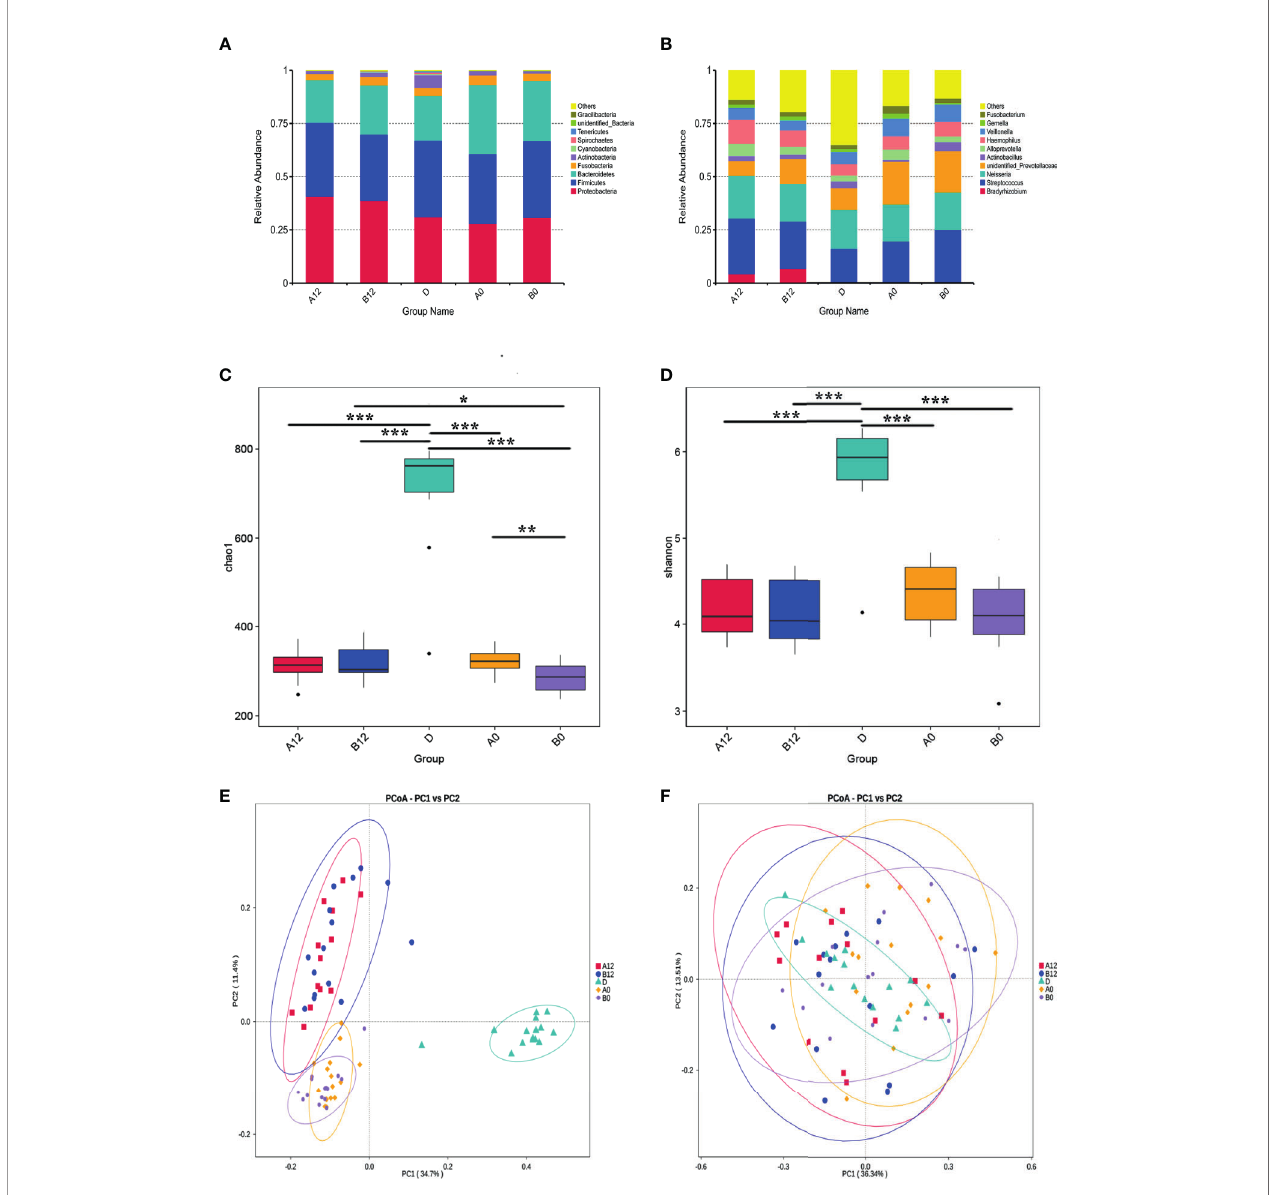
FIGURE 1 | The composition, relative abundance, and diversity of oral microbiota in HIV-infected groups and controls (A) at the phylum level; (B) at the genus level; (C) Alpha diversity exempli fi ed by the Chao1 index; (D) Alpha diversity exempli fi ed by the Shannon index; (E) Beta diversity represented by Principal coordinate analysis (PcoA) of unweighted UniFrac distances; (F) Beta diversity represented by Principal coordinate analysis (PcoA) of weighted UniFrac distances. A0, people living with acute HIV infection at baseline; B0, people living with chronic HIV infection at baseline; D, HIV-uninfected controls; A12, people living with acute HIV infection after 12 weeks of ART; B12, people living with chronic HIV infection after 12 weeks of ART. * p < 0.05; ** p < 0.01; *** p <